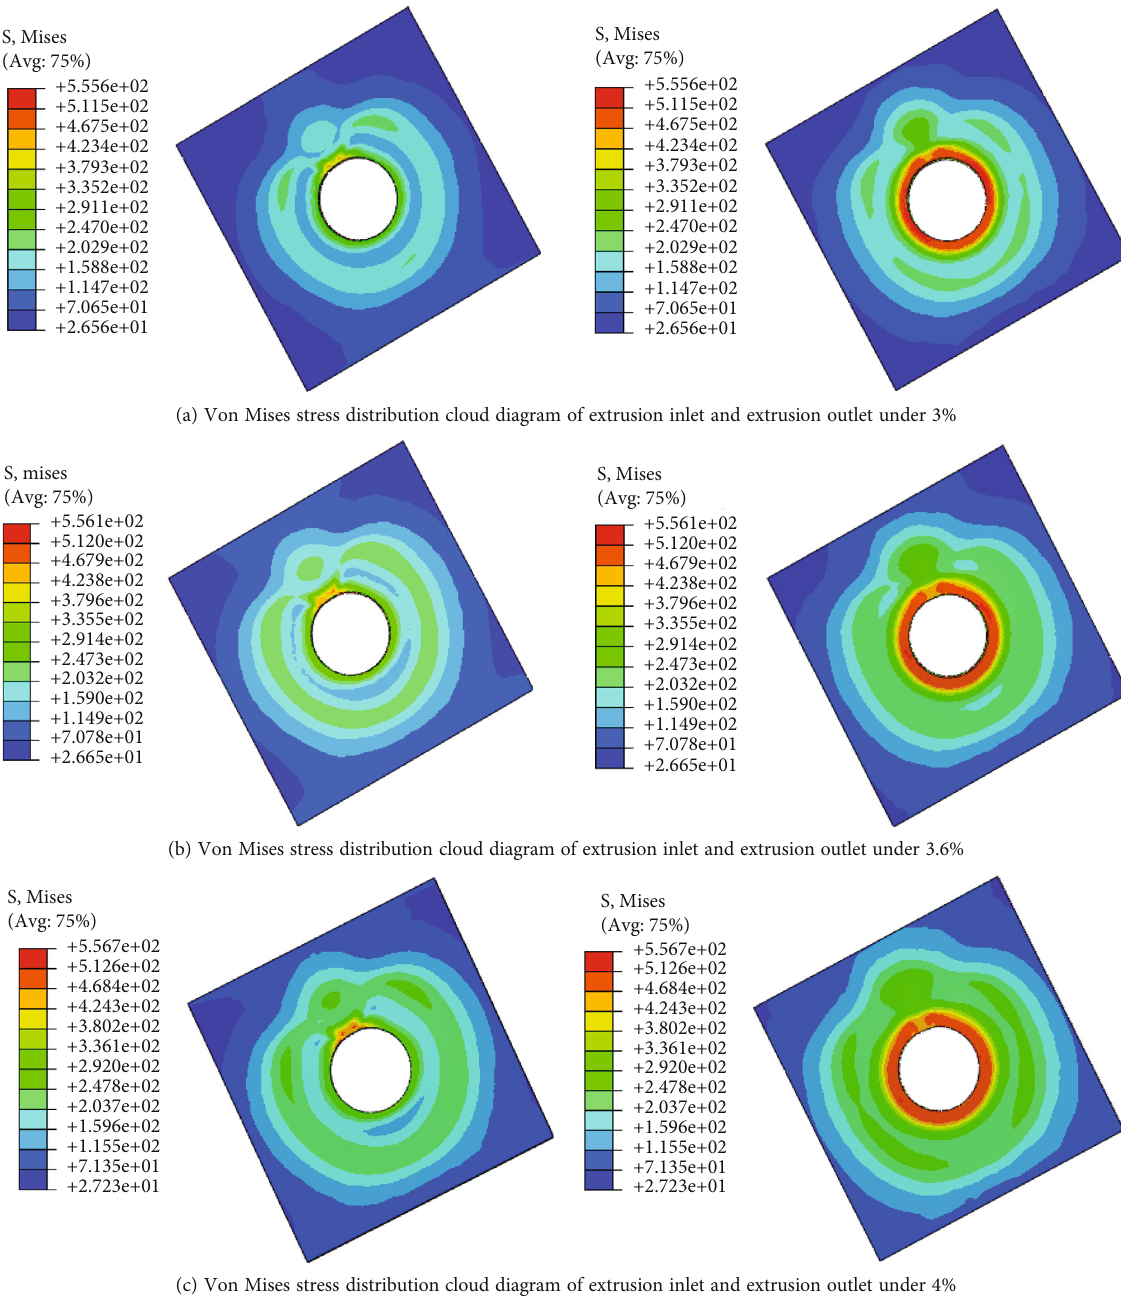
Figure 10: Von Mises stress distribution cloud diagram around the hole of the extrusion inlet and the extrusion outlet under di ff erent extrusion amounts (on the left is the extrusion inlet and on the right is the extrusion